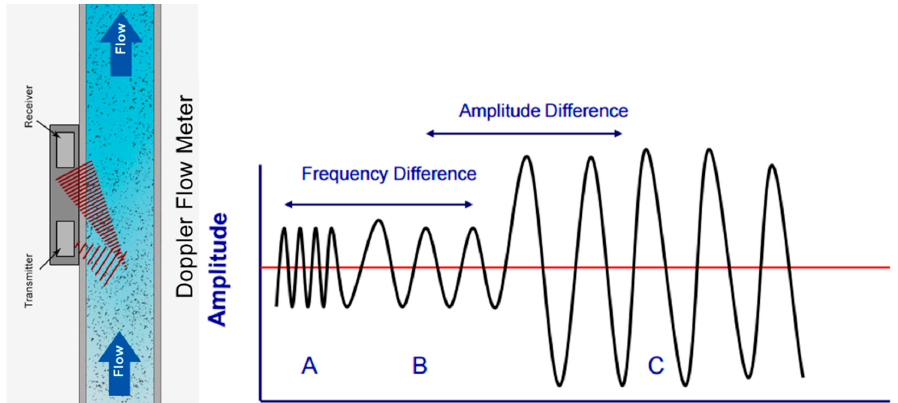
Figure 1. Doppler ultrasonic principle [24].